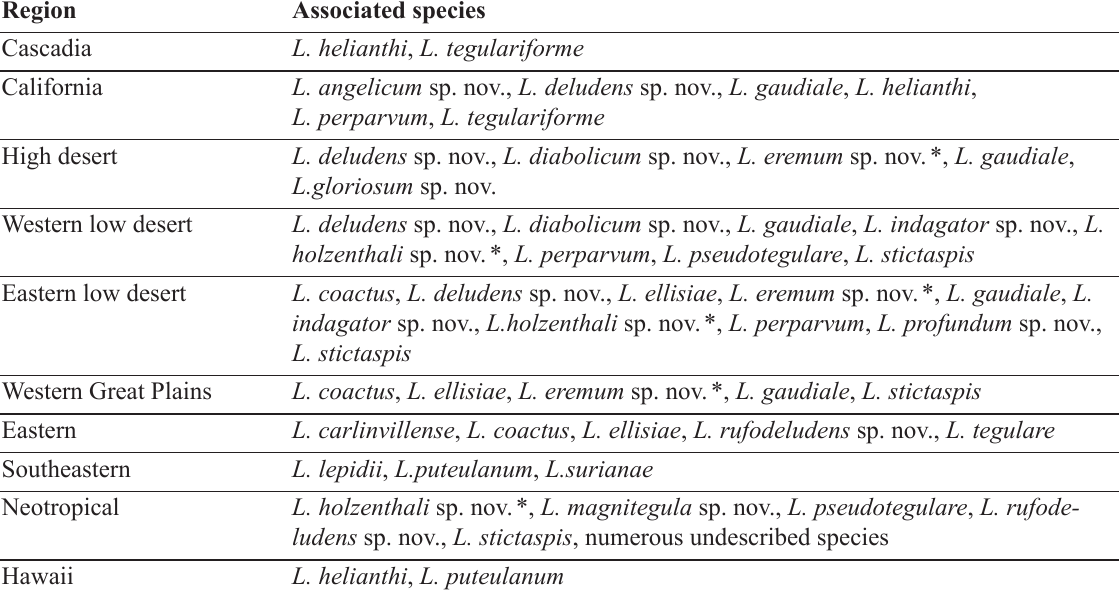
Table 2. List of species of L. gemmatum complex associated with major geographic regions defined in Fig. 77. These lists should not be considered absolutely inclusive but should be reliable near the centre of each region and become slightly less inclusive nearer to transition zones. Species marked with an asterisk occur primarily at high elevations or sky islands within the given